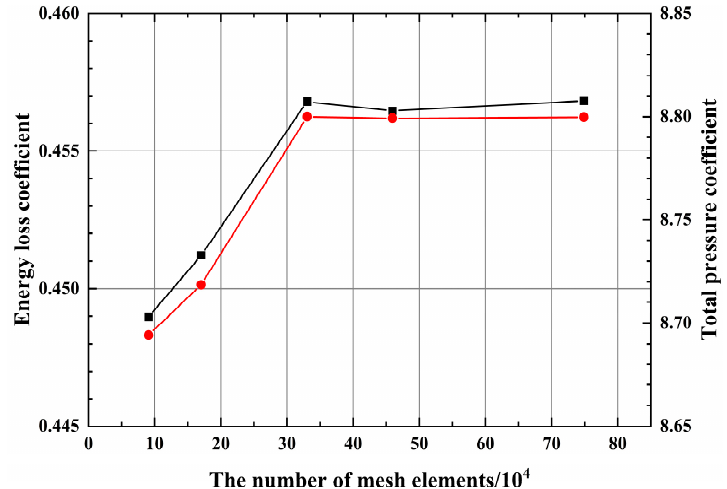
Figure 5. The grid independence test.